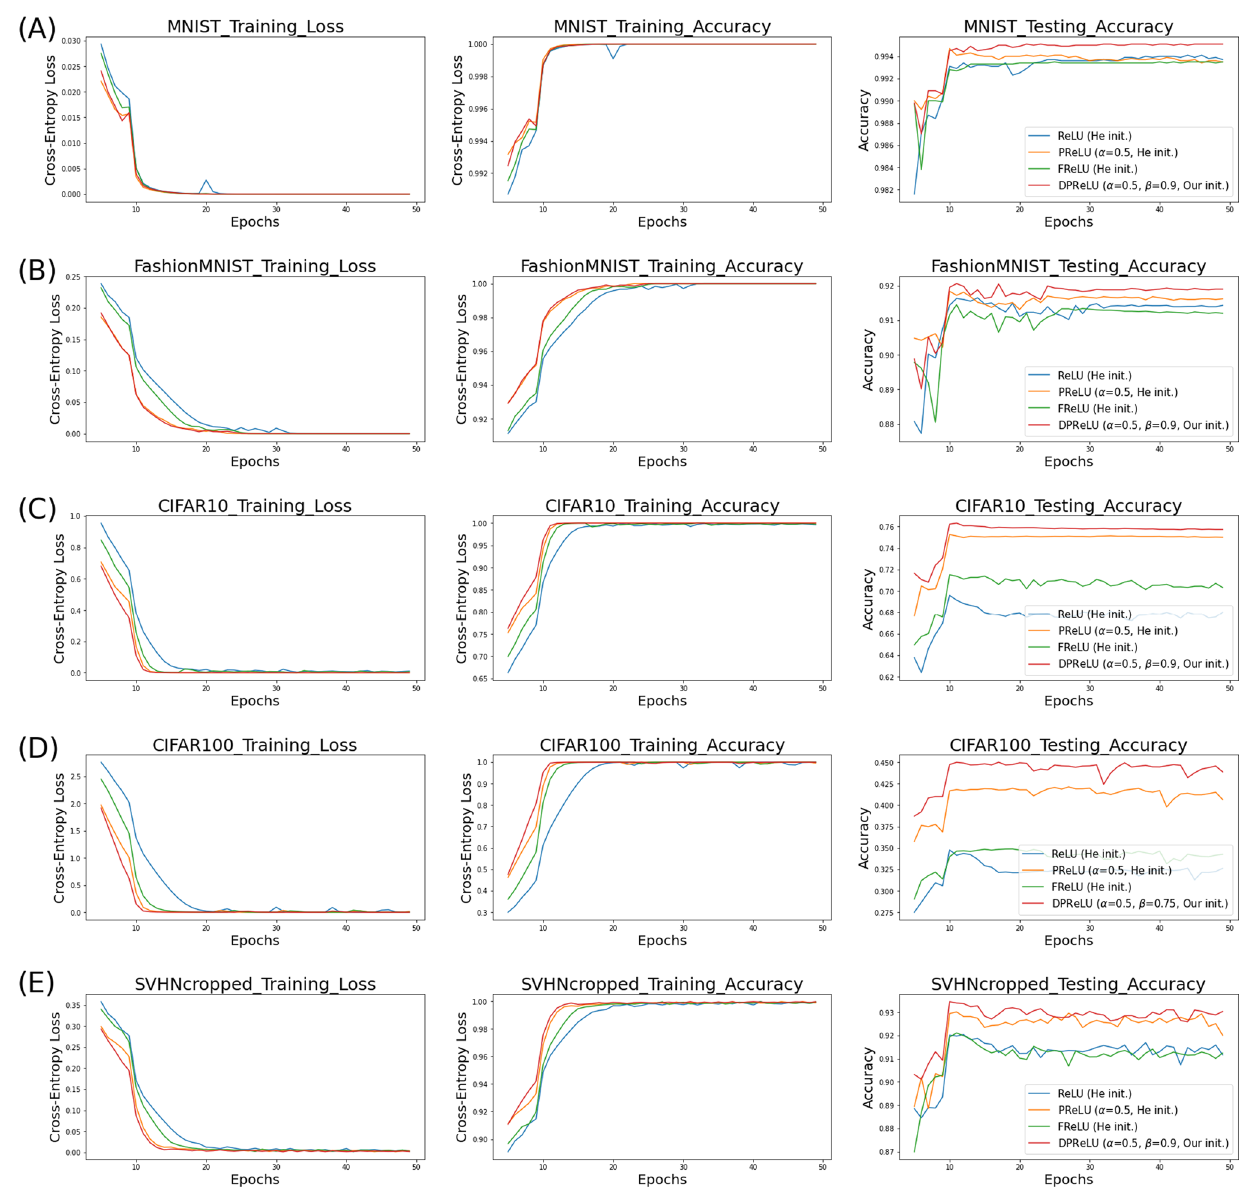
Fig. 5 Performance of the ResNet50 models using each activation with the weight initialization that performed the best on various image datasets. (5th epoch ∼ 50th epoch) ( 𝛼 and 𝛽 represent the initial